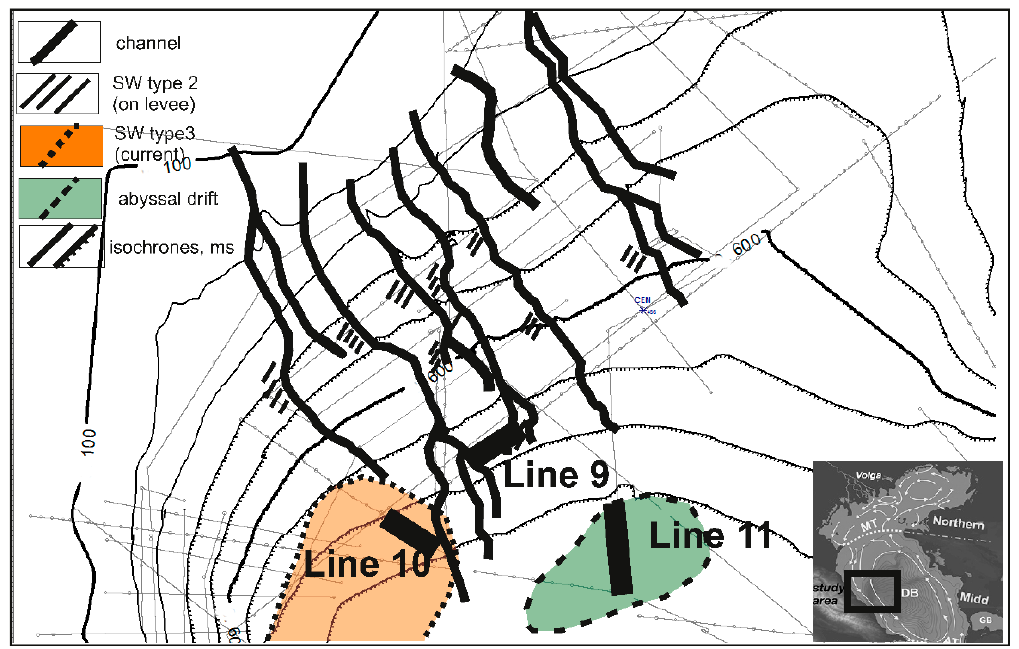
Figure 8. Scheme of modern channel system over the Mangyshlak Sill and contourites off the northern slope of the Middle Caspian Sea: sediment wave types 2 (on levee) and 3 (contourite) and abyssal drift. Lines 9, 10 and 11 show the positions of the seismic profiles shown in the corresponding figures.